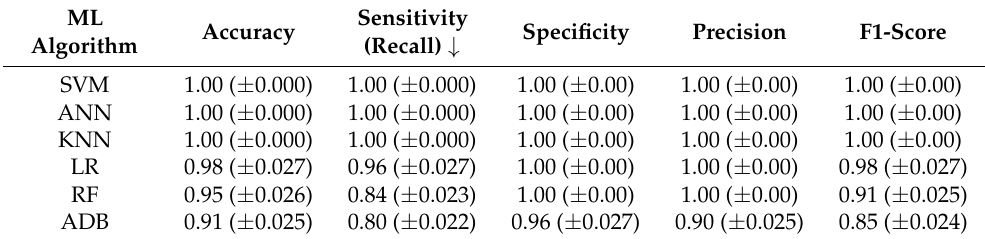
Table 3. Main classification metrics without hyper-parameters.